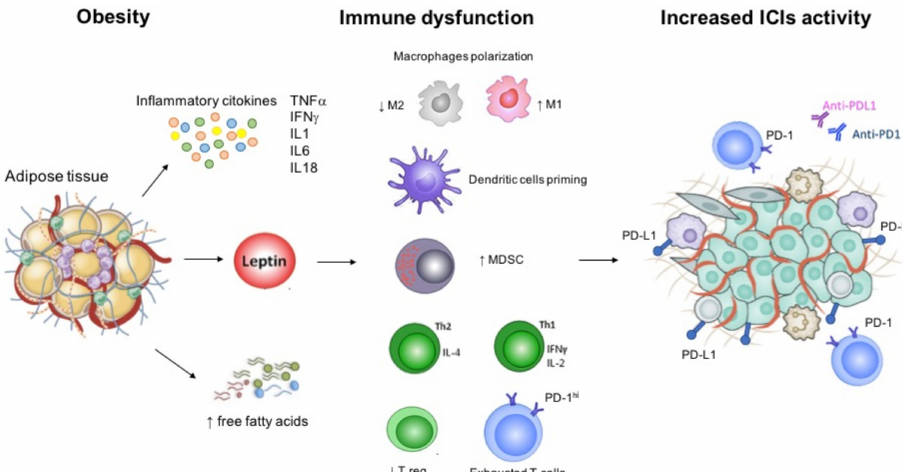
Figure 1. Immune dysfunction related with obesity and background for increased immunotherapy activity. Abbreviations: IFN, interferon; IL, interleukin; MDSC; myeloid derived stem cell; PD-1, programmed cell death 1; PD-L1, programmed cell death ligand 1; Th, T helper; TNF, tumor necrosis factor; T reg, regulatory T